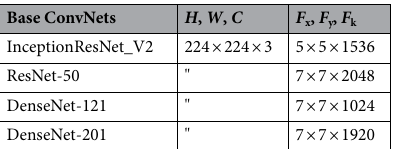
Table 2. Size of input images (H, W, C) and generated feature tensor (F x , F y , F k ) using four different base model.